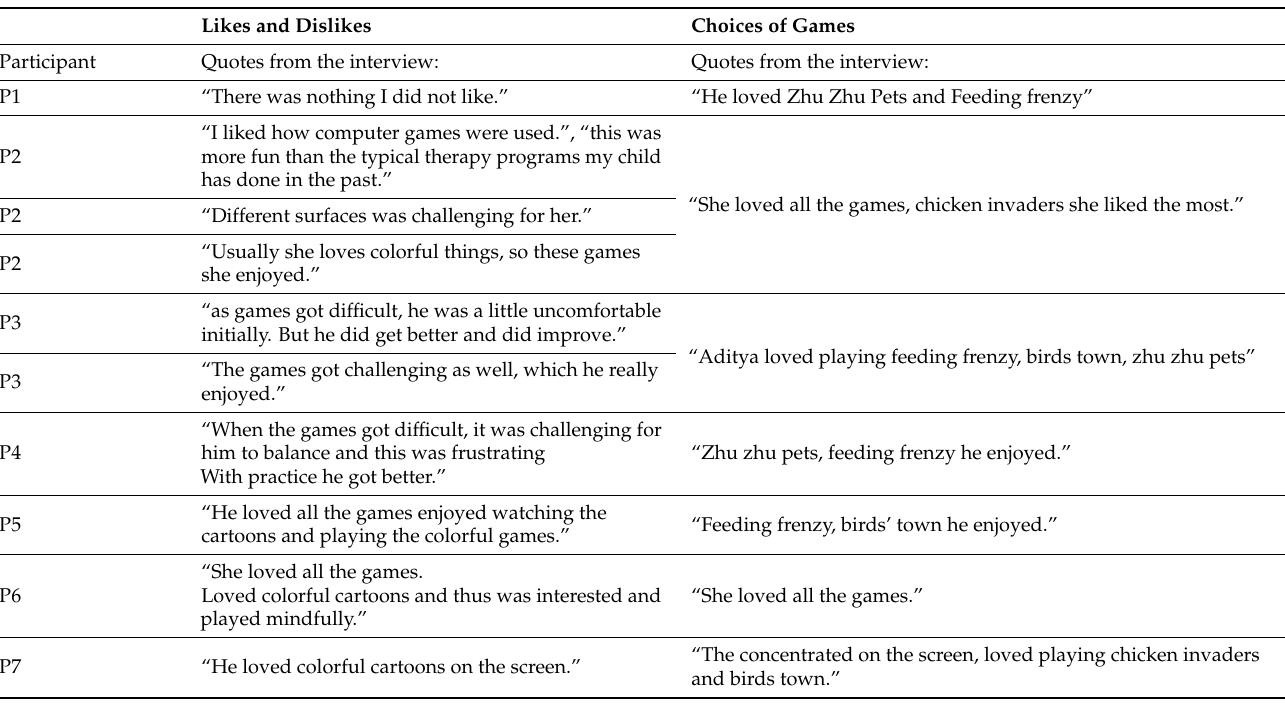
Table 3. Likes and dislikes.